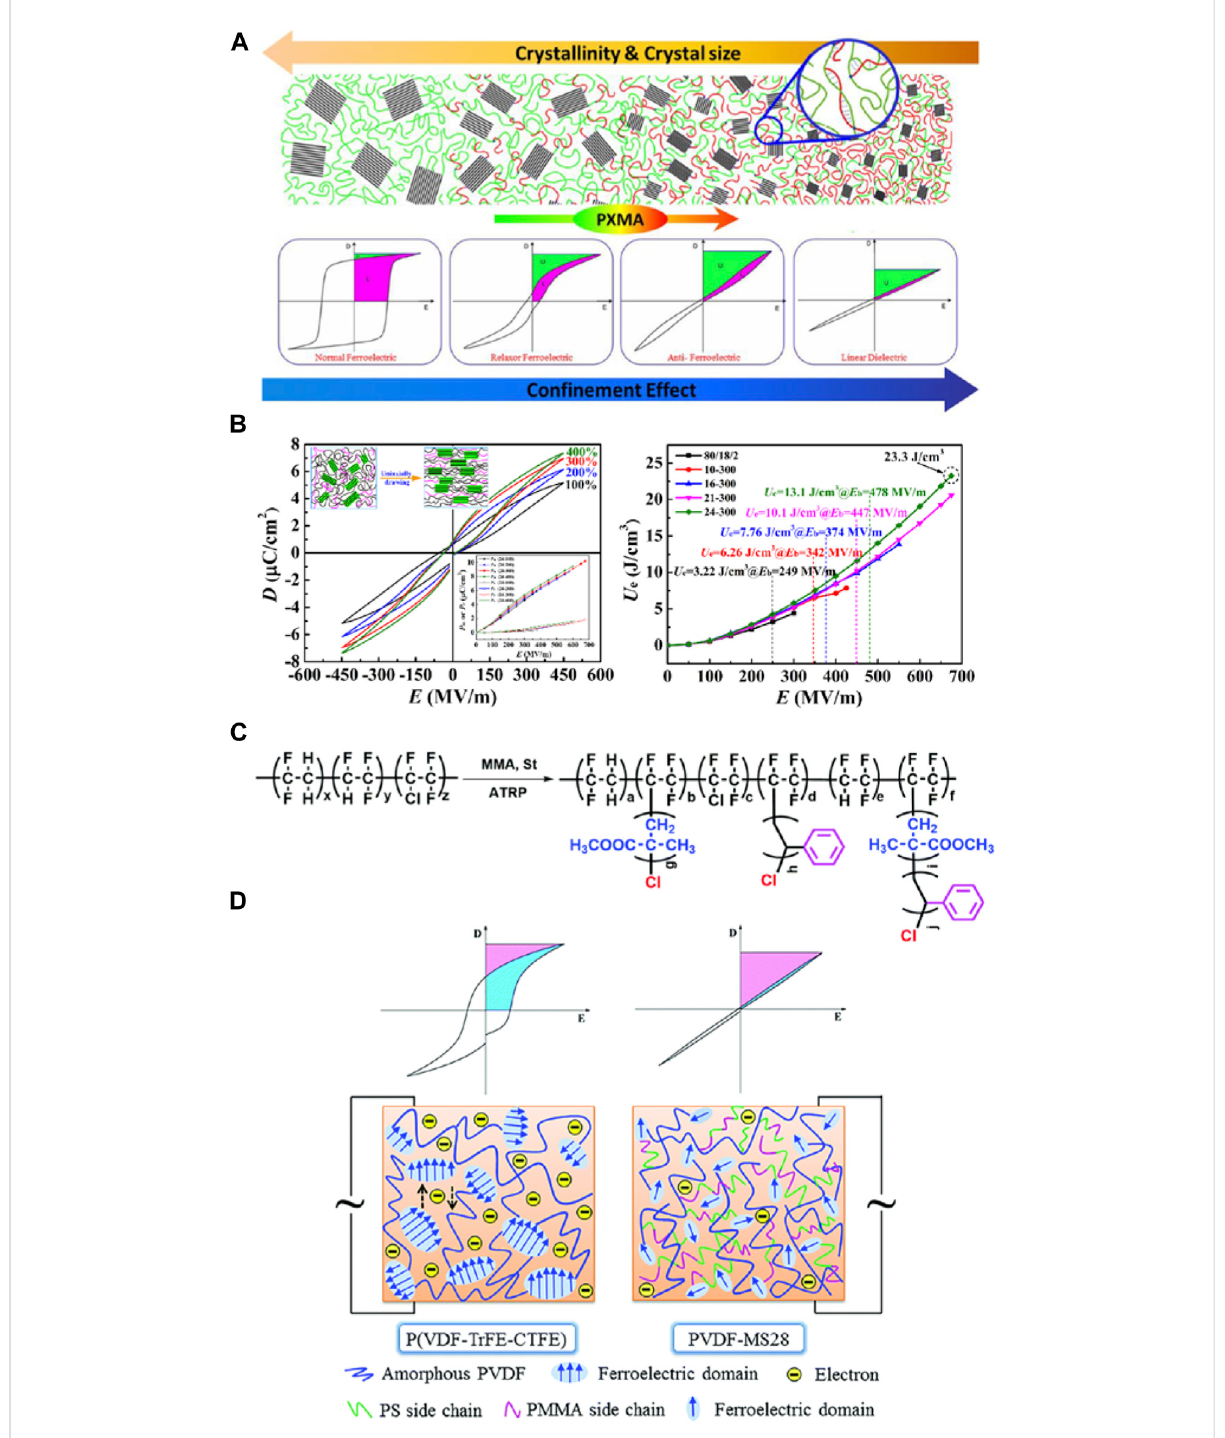
FIGURE 4 (A) Tuning phase transition and ferroelectric properties of P(VDF-TrFE) via grafting with desired poly (methacrylic ester)s as side chains; (B) High- fi eld antiferroelectric-like behavior in uniaxially stretched P(VDF-TrFE-CTFE)- g -PMMA fi lms with high energy density; (C) Synthesis of PVDF- MS copolymers using ATRP; (D) Schematic models of the molecular morphology of P(VDF-TrFE-CTFE) and PVDF-MS28. Reproduced with permission from Ref. 68, 70, and 71. Copyright 2013, 2016, and 2019 Royal Society of